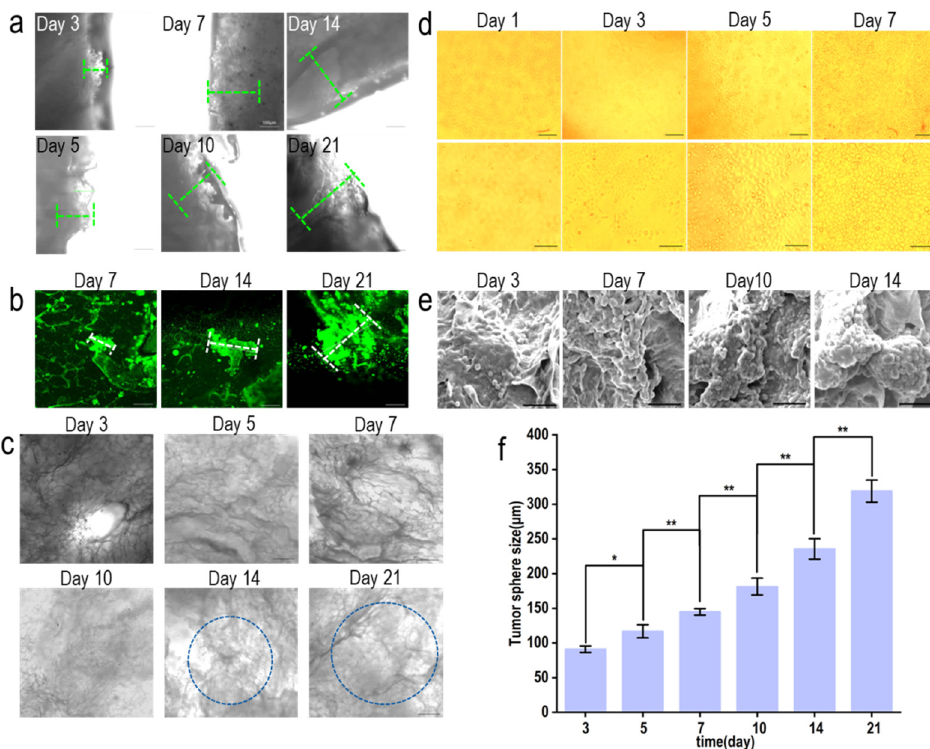
Figure 7. Tumor sphere size of MCF-7 cells after 3, 5, 7, 10, 14, and 21 days of renal matrix scaffold growth. ( a ) The tumor sphere size of MCF-7 cells at the edge of the scaffold was observed by inverted microscope 3, 5, 7, 10, 14, and 21 days after the growth of MCF-7 cells on the scaffold; scale: 100 µ m. ( b ) Fluorescence microscopy was used to observe the size of tumor spheres inside the scaffolds after MCF-7 cells grew on the renal scaffolds for 7 days, 14 days, and 21 days; scale: 100 µ m. ( c ) An inverted microscope was used to observe the overall distribution of MCF-7 cells cultured on the renal matrix scaffold 3, 5, 7, 10, 14, and 21 days later; scale: 200 µ m. ( d ) MCF-7 cells were cultured on 24-well plates for 1, 3, 5, and 7 days with inverted microscope; scale: 200 µ m (up), 60 µ m (bottom). ( e ) Scanning electron microscopy was used to detect the size of tumor spheres of MCF-7 cells cultured on a renal matrix scaffold 3, 7, 10, and 14 days later; scale: 50 µ m. ( f ) Combined with inverted microscope, scanning electron microscope, and laser confocal microscope images, IPP software was used to quantitatively measure the tumor sphere size inside and at the edge of the scaffold; * p < 0.05, ** p <